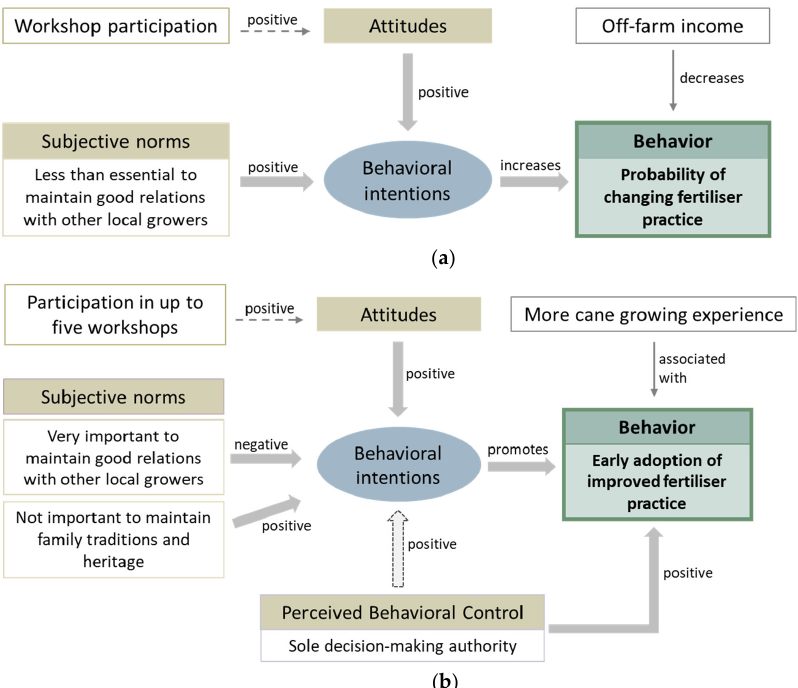
Figure 1. Mapping of empirical results from this study to the Theory of Planned Behavior. ( a ) Results from the logistic regression of Model 2: factors influencing the probability of fertilizer practice change; ( b ) Results from the negative binomial regression of Model 2: factors influencing early adoption of practice change.